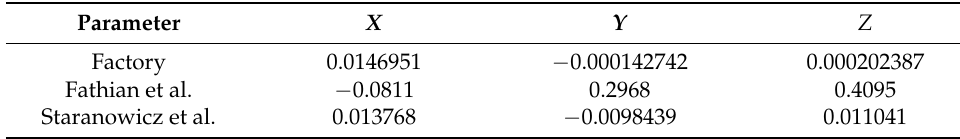
Table 4. Depth camera (RGB-D) translation